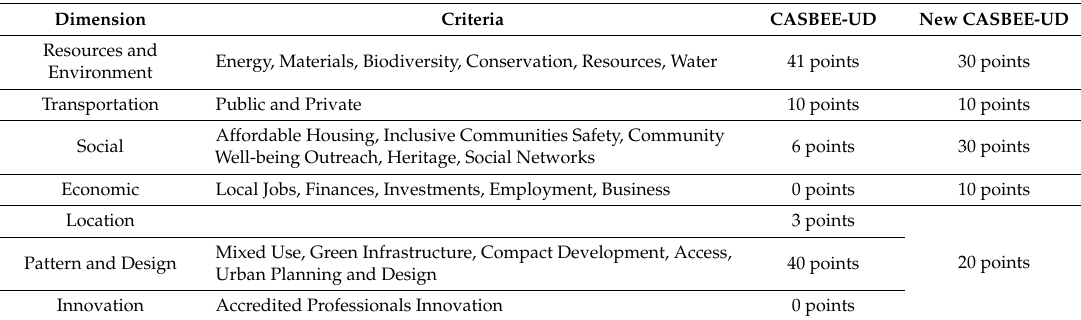
Table 9. Integration indicators in the new tool and allocation of points for each dimension.